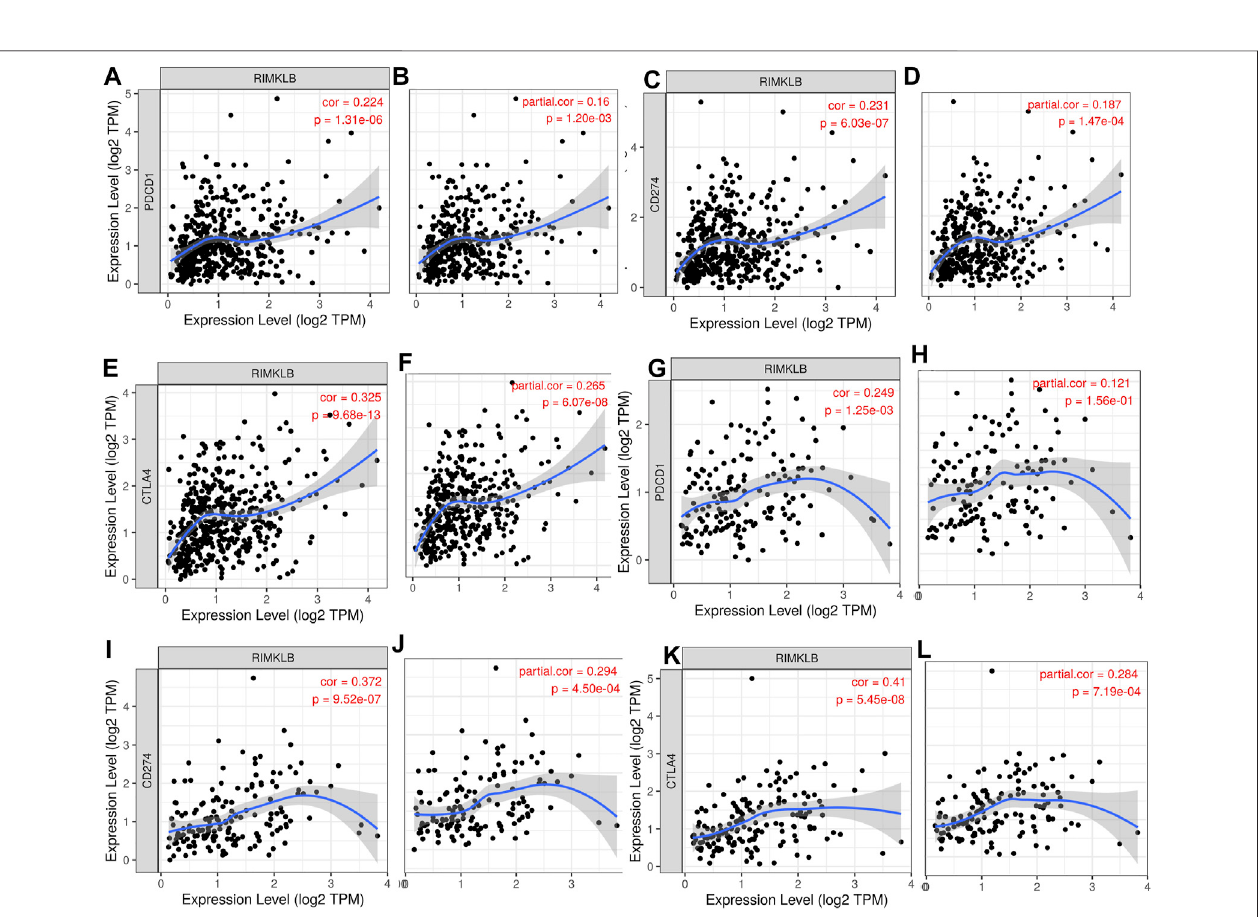
FIGURE 6 | Correlation of RIMKLB expression with PD1, PDL1, and CTLA4 in COAD, and READ. RIMKLB expression has signi fi cant positive correlations with in fi ltrating levels of PD1 (A,B) , PDL1 (C,D) and CTLA4 (E,F) before and after purity adjustment in COAD; As well as in READ [PD1 (G,H) , PDL1 (I,J) and CTLA4 (K,L) ].